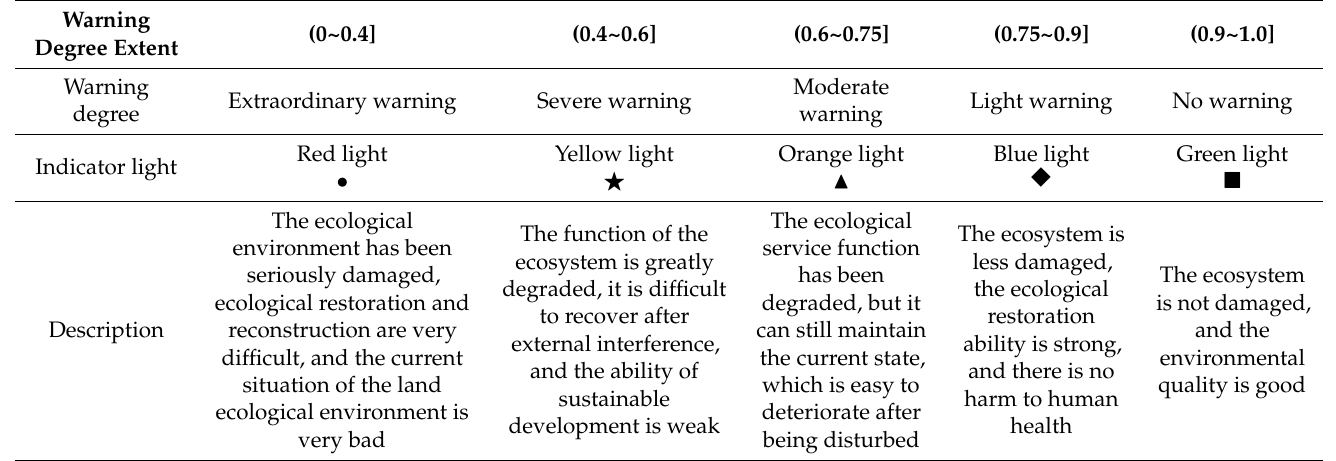
Table 2. Warning standard of TEH in Henan Province.